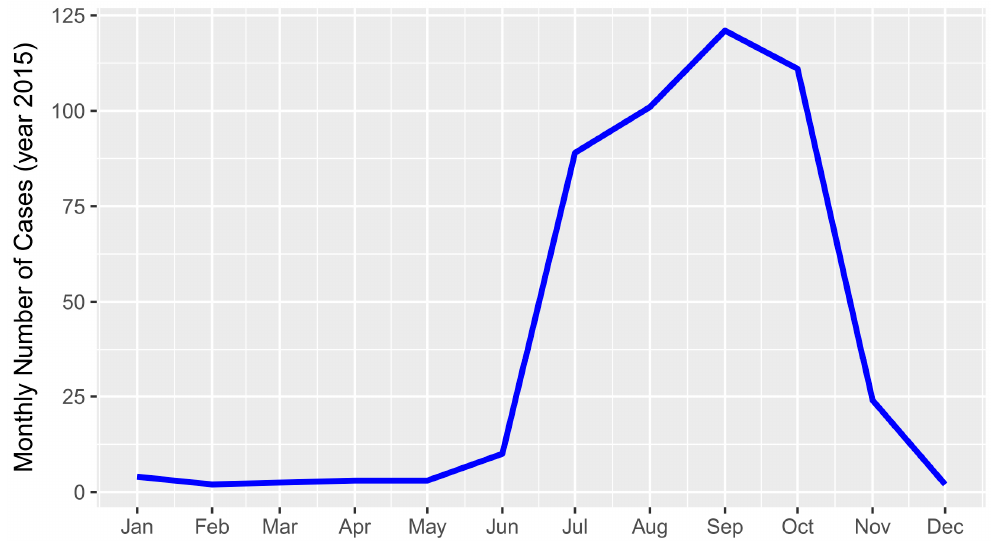
Figure 5. Temporal distribution of 470 clinically suspected scrub typhus cases that tested positive to the SD Bioline Tsutsugamushi test in Bhutan in 2015. Table 1. Comparison of the clinical manifestations of 470 clinically suspected ST cases that tested positive to the SD Bioline Tsustugamushi test in males (241) and females (229) in Bhutan in